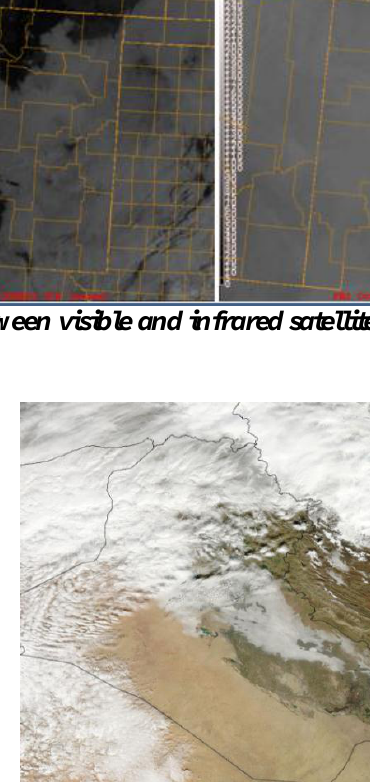
Fig. 7: Fog over Baghdad in 17/12/2015 detect by terra MODIS satellite as can be seen fog take the shape of terrain.